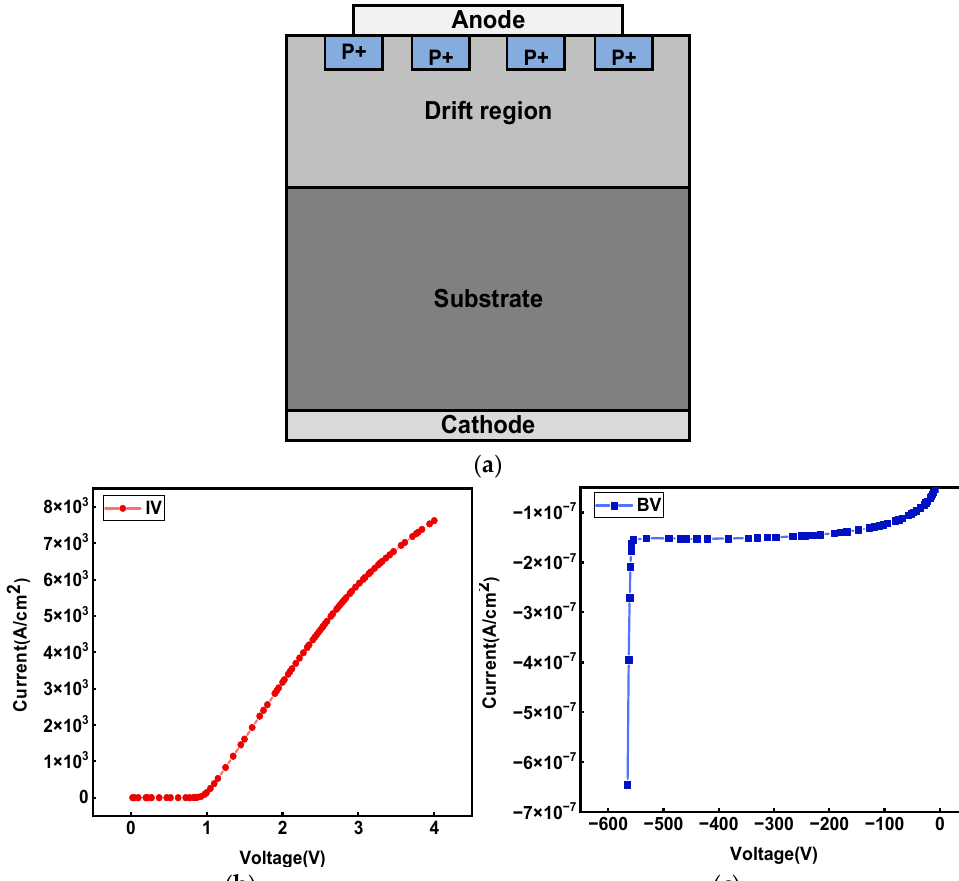
Figure 1. Figure ( a ) shows the schematic diagram of GaN JBS device structure, and the forward and reverse features of GaN JBS device under the structural parameters given in Table 1: ( b ) forward I ‐ V curve, ( c ) reverse I ‐ V curve.